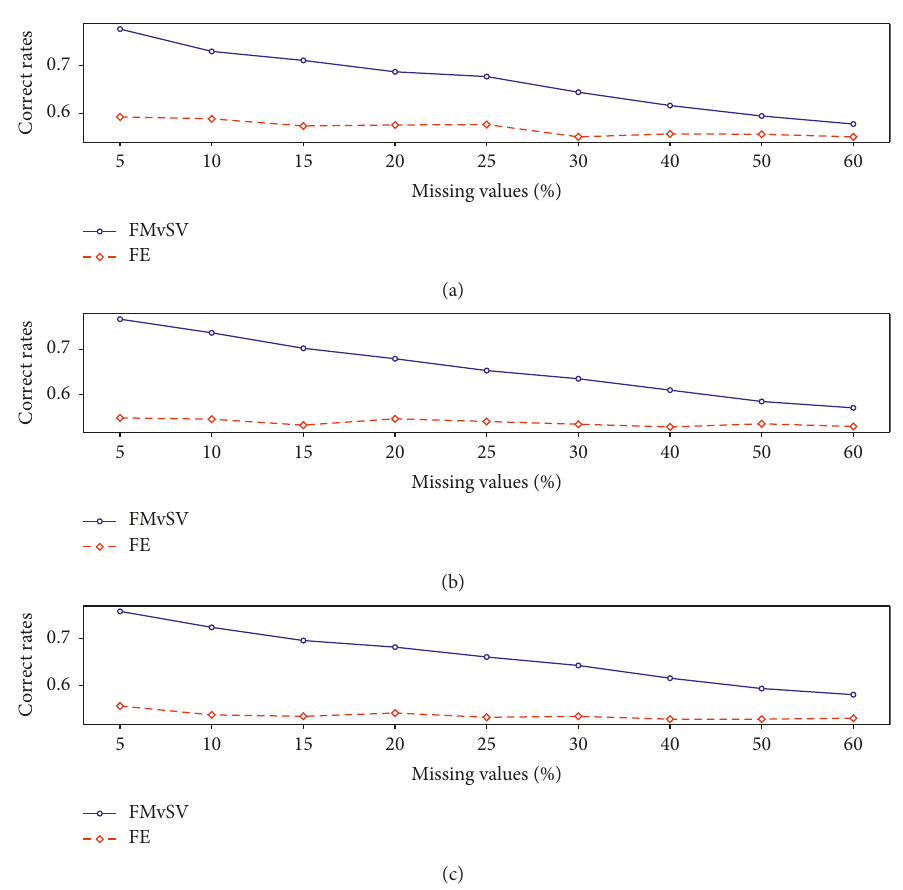
Figure 4: Comparison of the correct rates of Algorithms FMvSV and FE in terms of (a) AD200, (b) AD400, and (c)